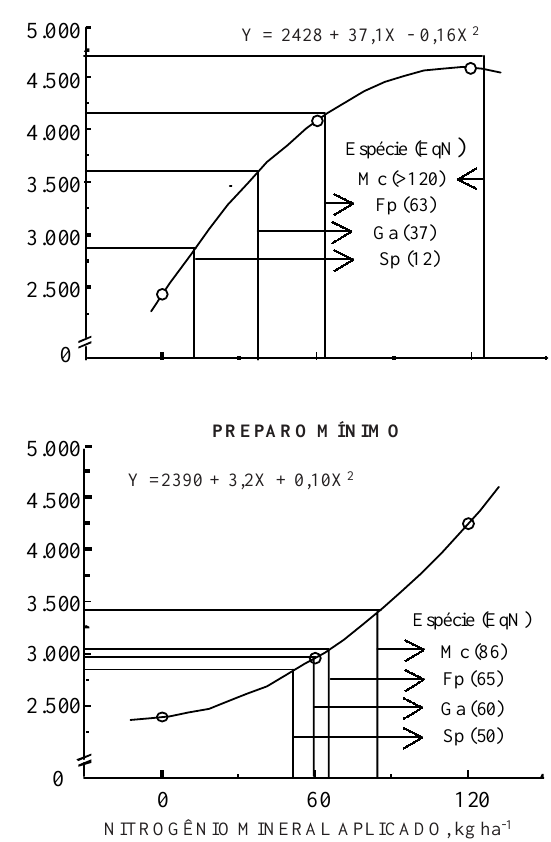
Figura 2. Equivalência em nitrogênio mineral (EqN, kg ha -1 de N) do cultivo intercalar ao milho de espécies leguminosas estivais, nos sistemas de preparo convencional (PC) e preparo mínimo (PM). A regressão representa o incremento no rendimento de grãos do milho com aplicação de N mineral no tratamento-testemunha, sem leguminosa intercalar. Média de quatro safras no PC e de cinco safras no PM e de três repetições (Mc = mucuna cinza; Fp = feijão-de- porco; Ga = guandu anão; Sp = soja